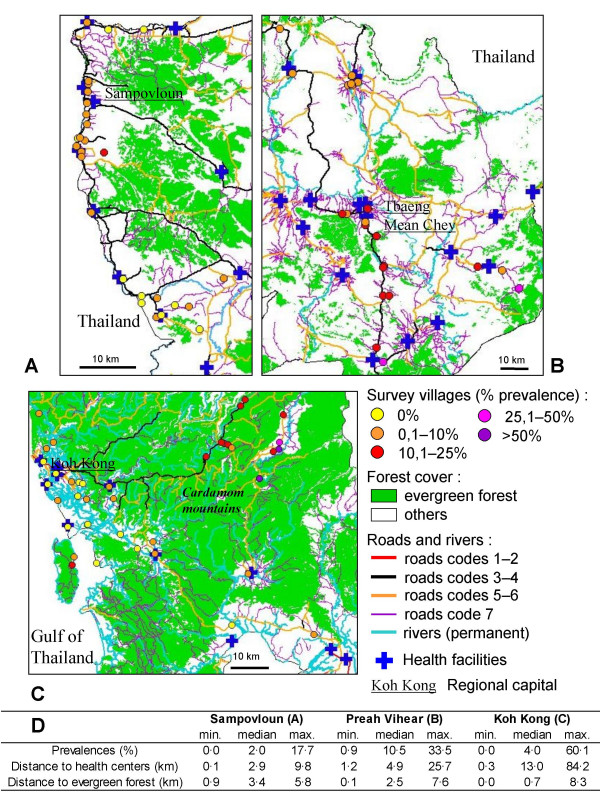
Maps of the study areas Sampovloun (A), Preah Vihear (B) and Koh Kong (C). Maps 2A, B and C show the distribution of microscopy-based age/gender-standardized malaria prevalence in the surveyed villages, evergreen forest, roads according to their quality (codes 1–2: hard surface roads passable in all weather, codes 3–4: loose surface roads passable in all weather, codes 5–6: cart tracks and loose surface roads passable in dry weather only, code 7: footpaths), rivers, and positions of public health facilities. Figure 2D shows the median, minimum and maximum values of village-based age/gender-standardized Plasmodium prevalence, distances to public health facilities and distances to evergreen forest.